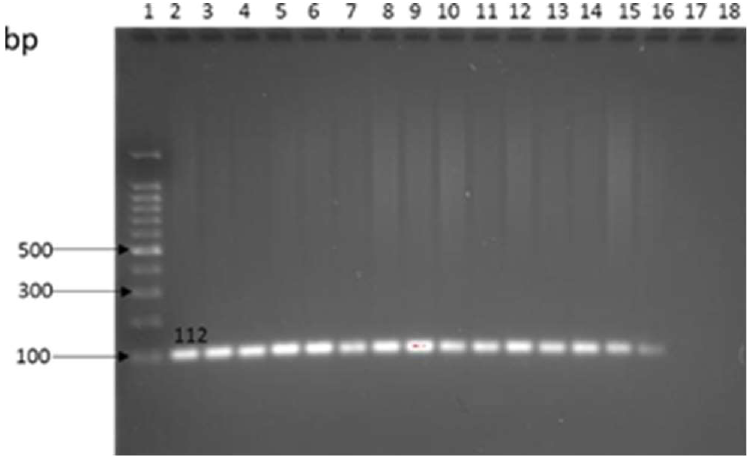
Figure 4. Amplification of the Tuf gene in Enterococcus spp. Lane 1: 1 kb ladder, lane 2: Enterococcus faecium ATCC 35667 positive control, lane 3–17: samples, lane 18: water negative